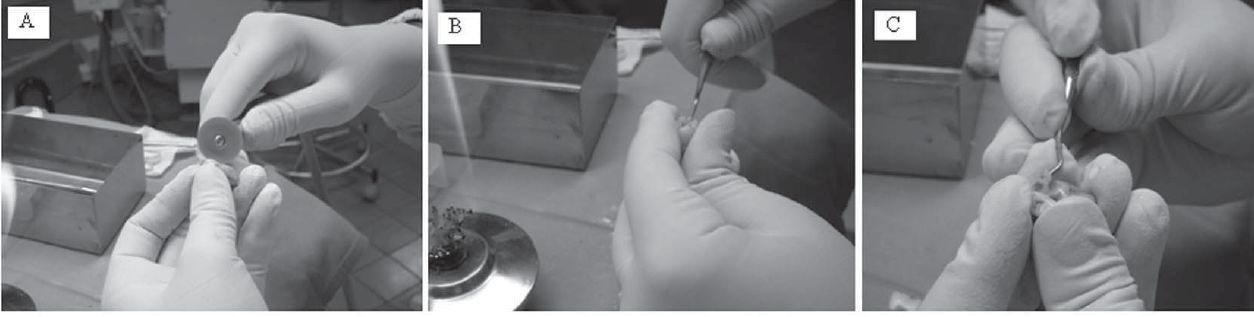
Fig. 1. Permanent tooth immediately after extraction, manipulated with sterile gloves and close to a burning flame. Longitudinal groove made using a diamond disk without reaching the pulp tissue (A). Tooth sectioning using a dentinal excavator (B). Pulp tissue removal from tooth crown and root